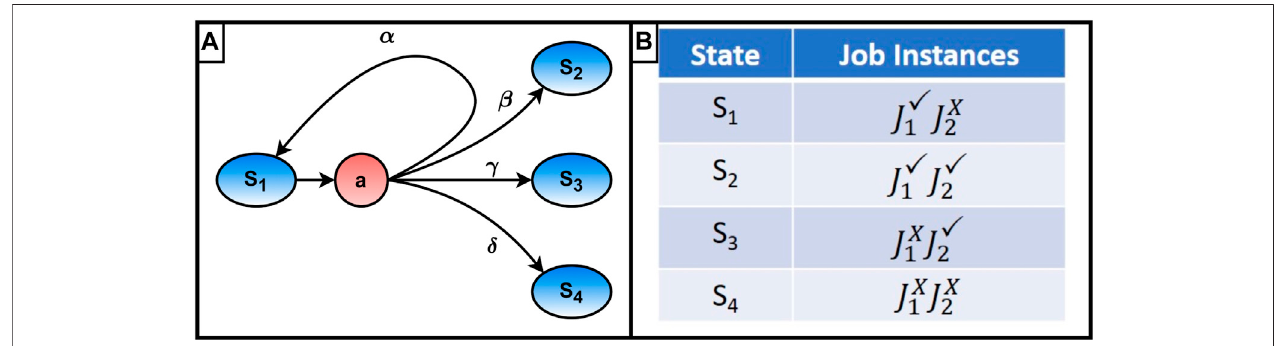
FIGURE 1 | (A) Example Markov decision process state transition graph, (B) States in example Markov decision process.